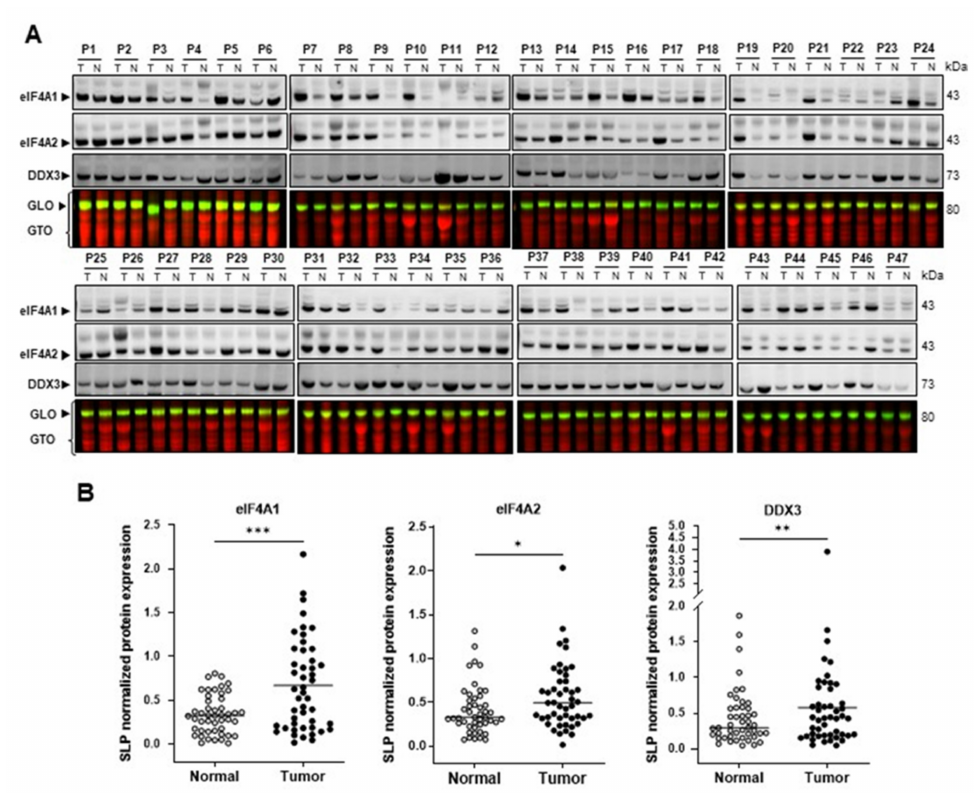
Figure 2. eIF4A1 is upregulated in human hepatocellular carcinoma (HCC; n = 47). ( A ) Levels of eIF4A1, eIF4A2, and DDX3 proteins in human HCC samples, as detected by western blotting using the SPL method. ( B ) Quantification of western blot band intensities. Dots representing the individual protein expression of one patient and their medians are shown (* p < 0.5; ** p < 0.1; *** p < 0.01; Wilcoxon matched-pairs signed rank test). Abbreviations: P, patient; T, tumor; N, non-tumor; GLO: Gel loading control (green); GTO: Total protein (red).